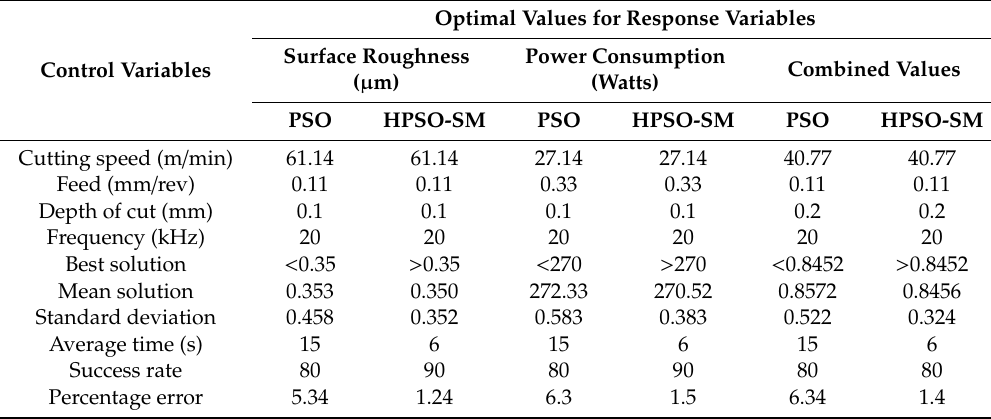
Table 9. Control variables and their selected values (for optimal response